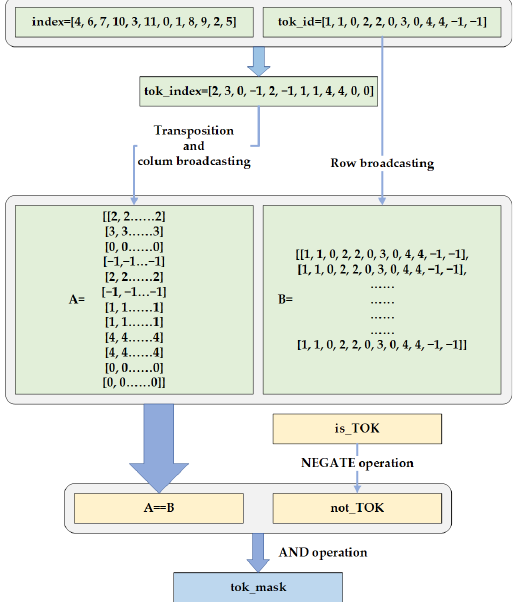
Figure 9. Generation of the tok_mask matrix.